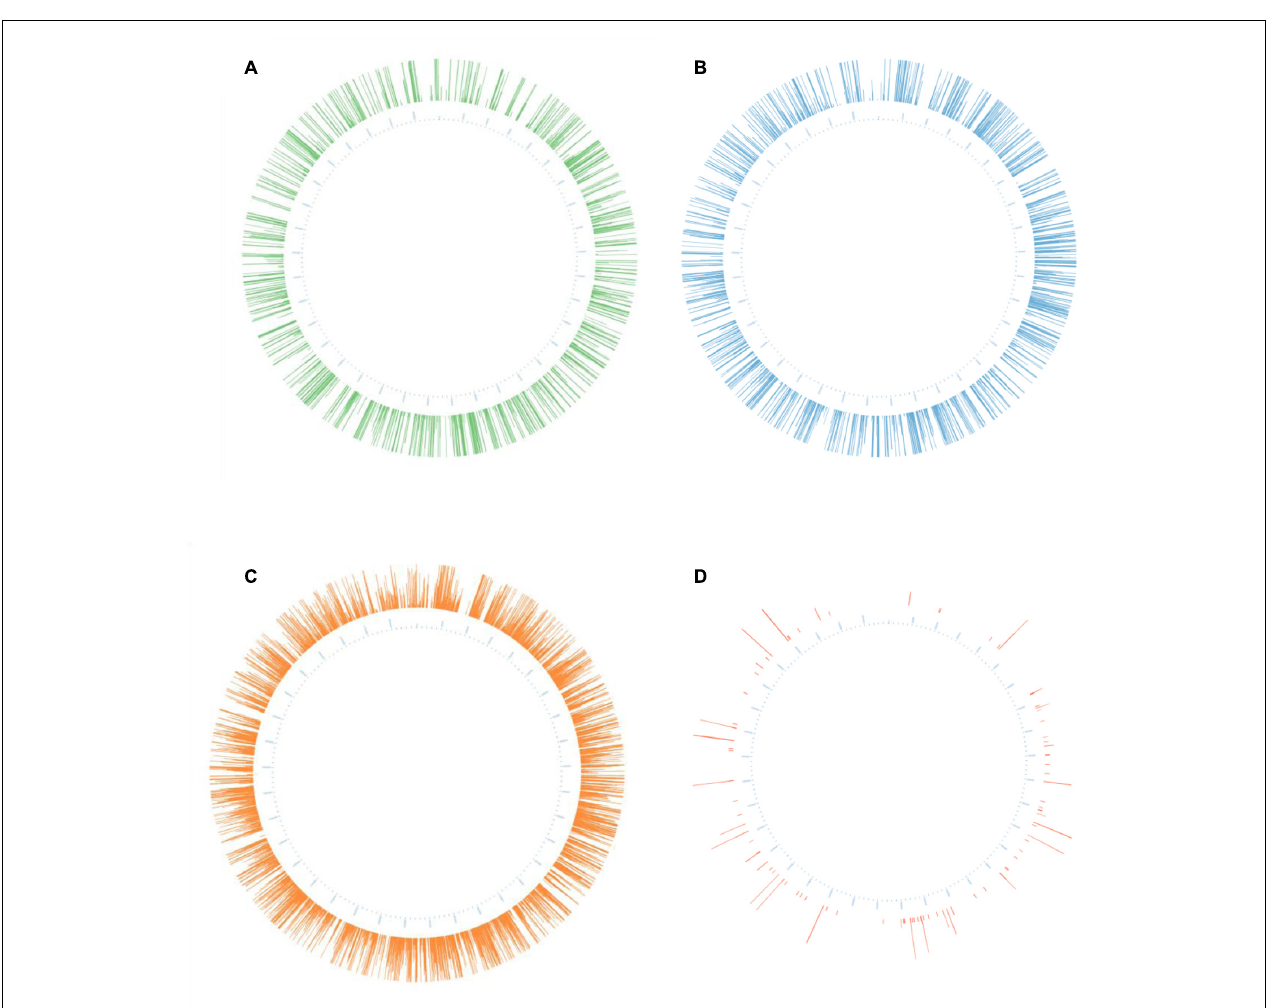
FIGURE 1 | Representation of unique insertions following analysis of different sequencing libraries. The genomic coordinates of each unique insertion were used to generate corresponding Circos plots (Krzywinski et al., 2009) of mutations in the genome of Streptococcus uberis . The height of each line represents mutation read depth (set to a maximum of fifty reads and a minimum of three). The libraries were generated from (A) EcoR1 digested DNA; (B) HindIII digested DNA; (C) Acoustically fragmented DNA; or (D) Unenriched gDNA.